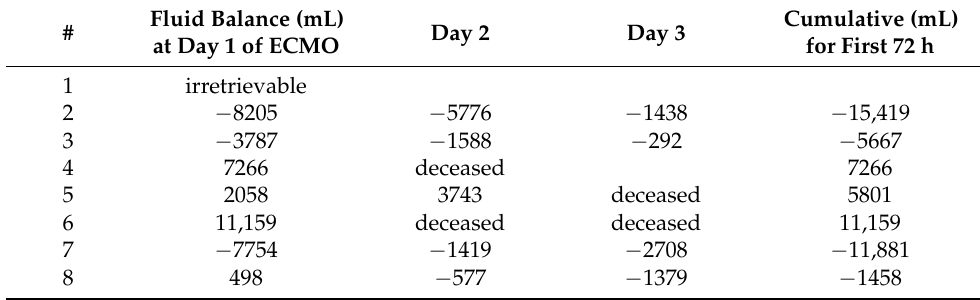
Table 5. Fluid balance (mL) before